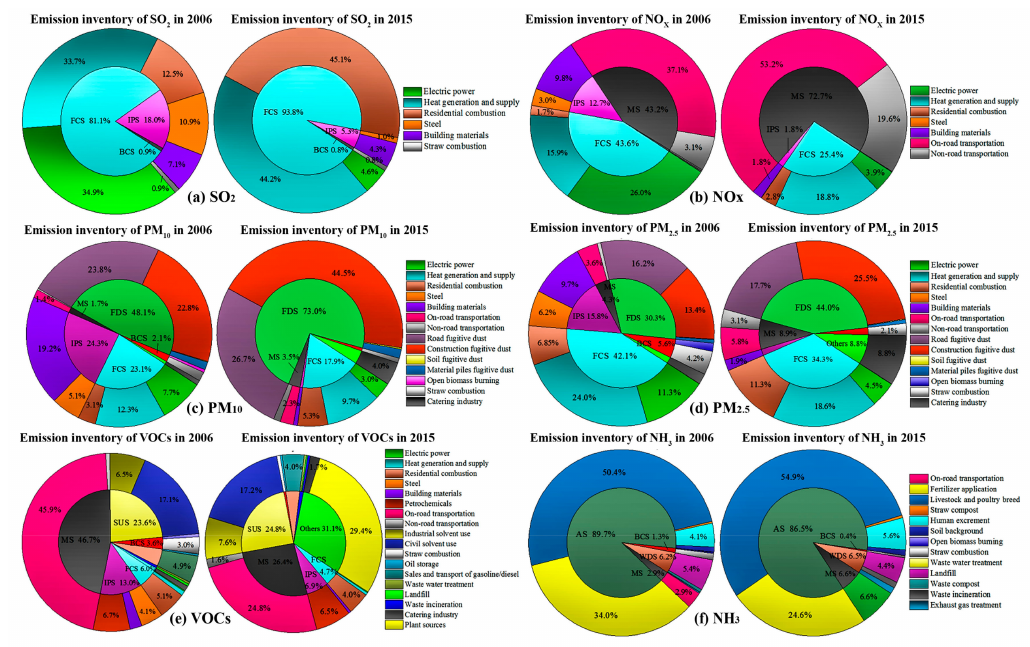
Figure 3. Comparison of the proportions of pollutant emissions from di ff erent source categories between 2006 and